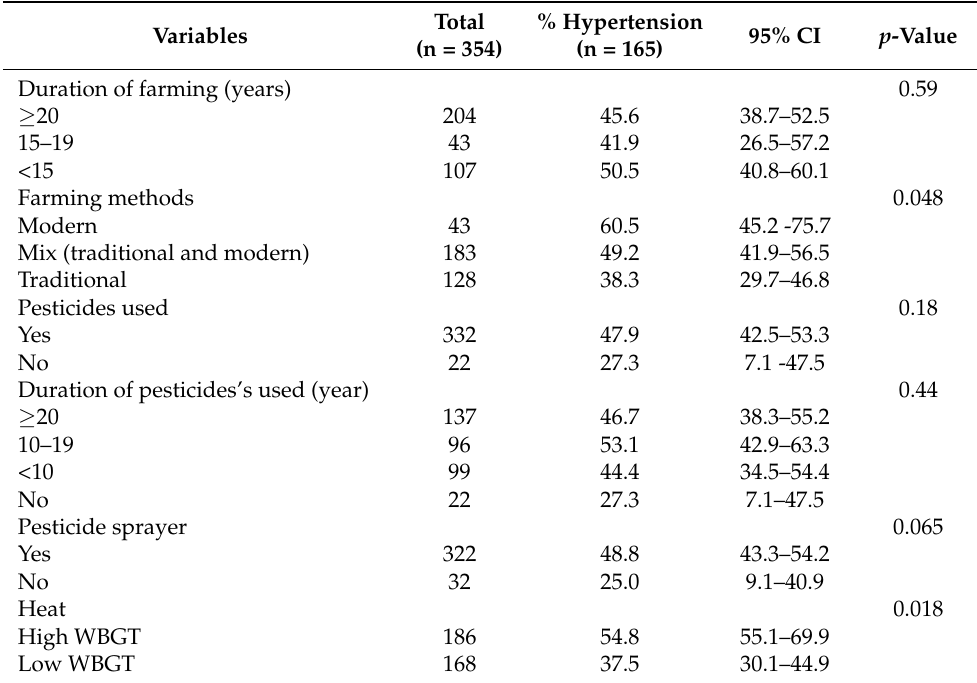
Table 3. Prevalence of hypertension based on occupational factors in Karawang and Bogor in West Java, Indonesia 2018.